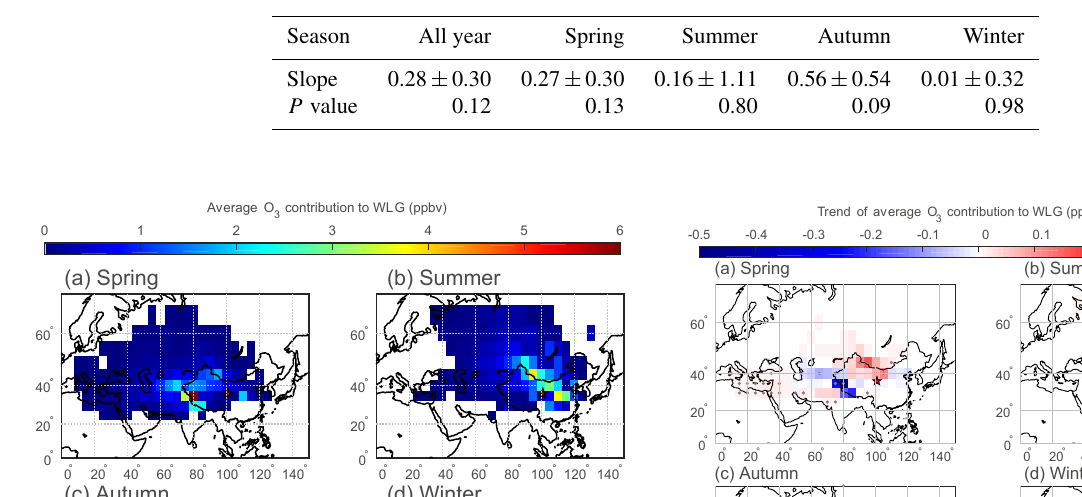
Table 2. Trend of total contribution of direct ozone transport to WLG ozone concentration (ppbvyr − 1 ); confidence intervals are given for p < 0 . 1.